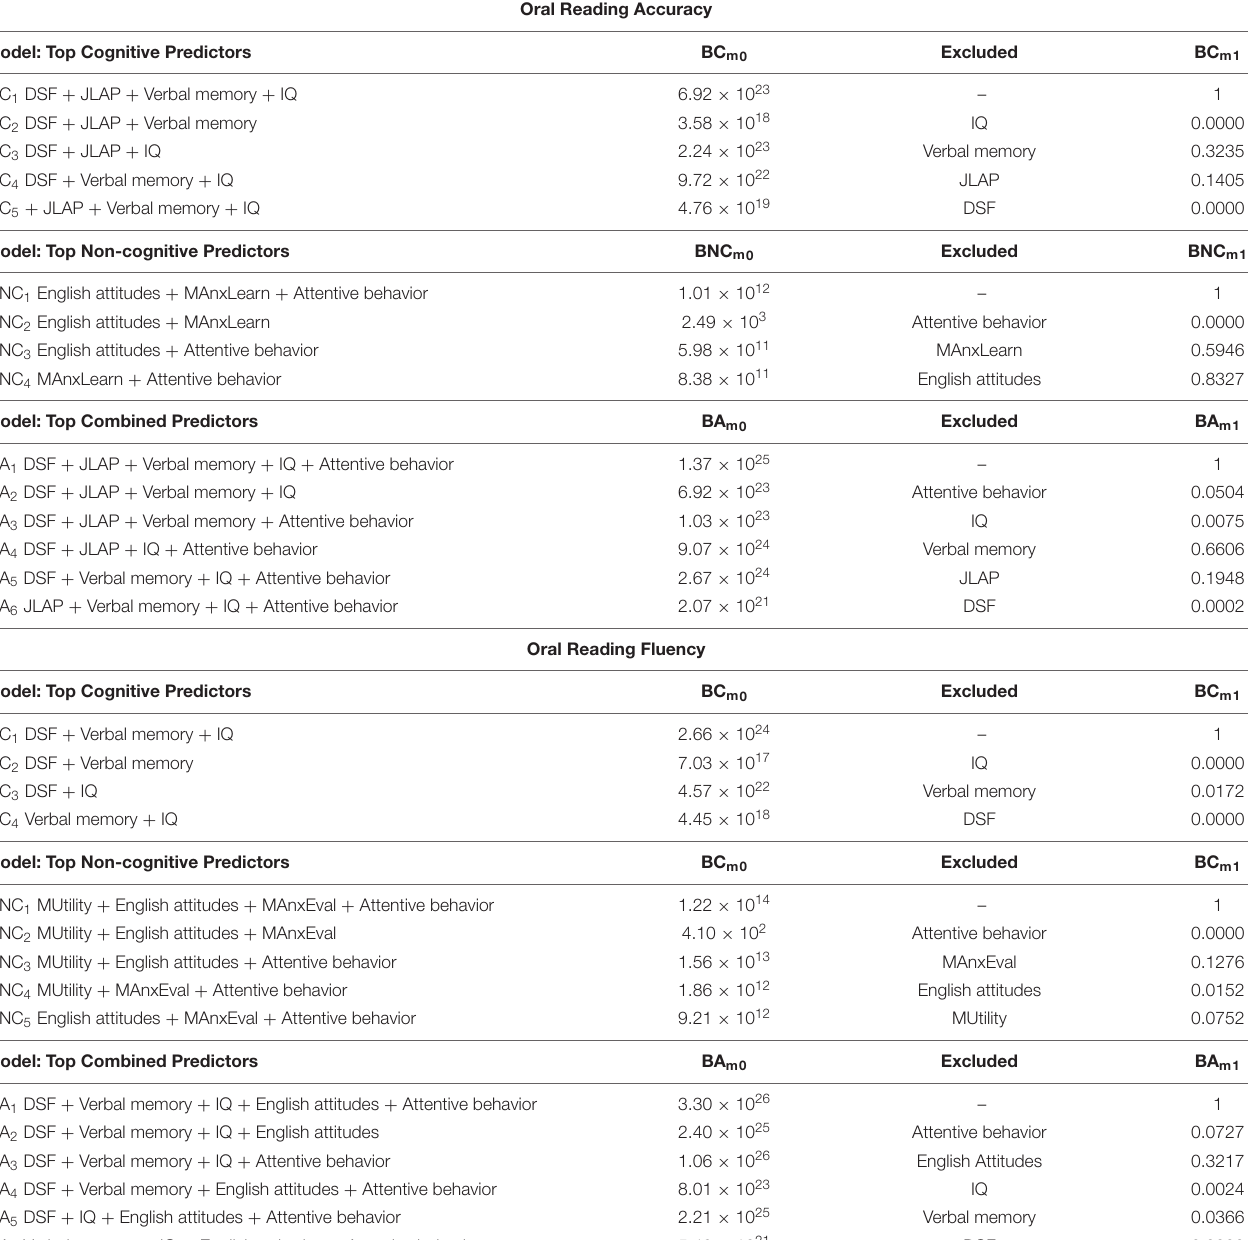
TABLE 3 | Bayes factor analyses of predictors of oral reading